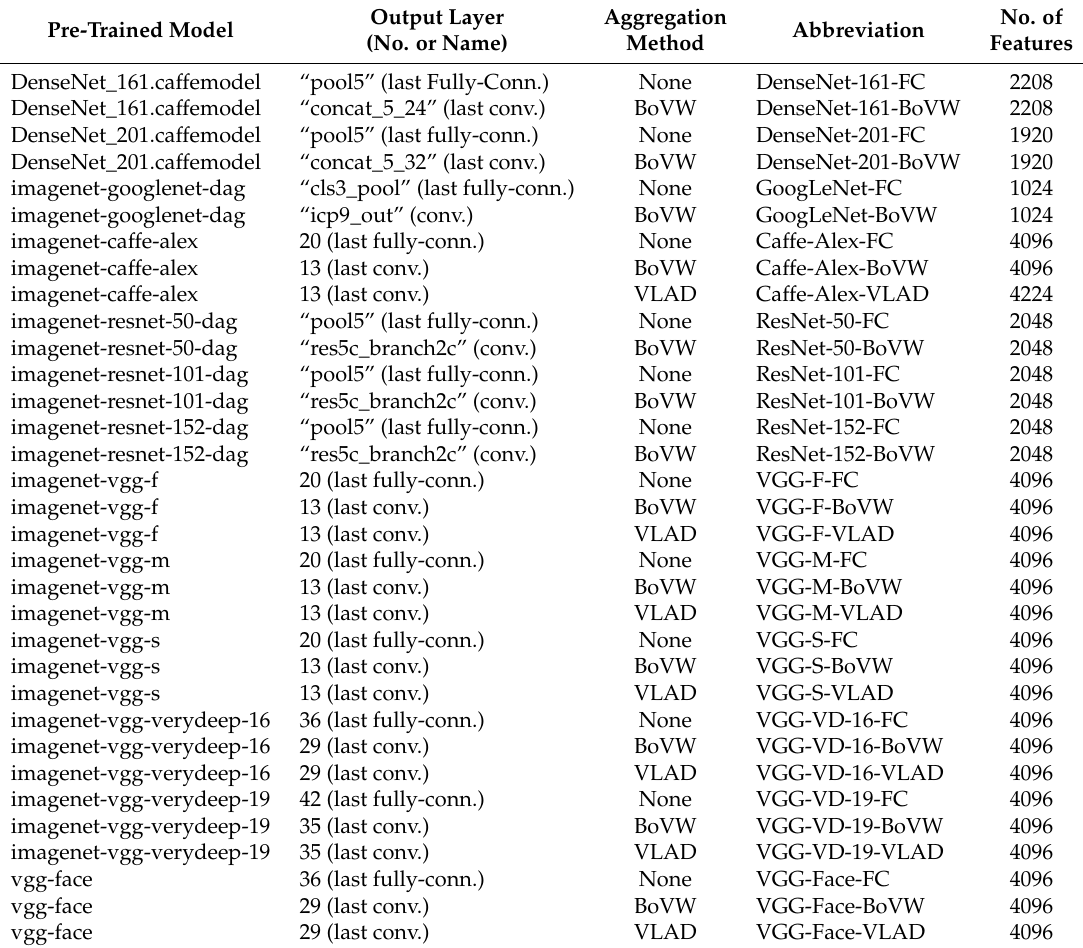
Table 3. Summary table of the off-the-shelf CNN-based features used in the experiments. Output Pre-Trained Model